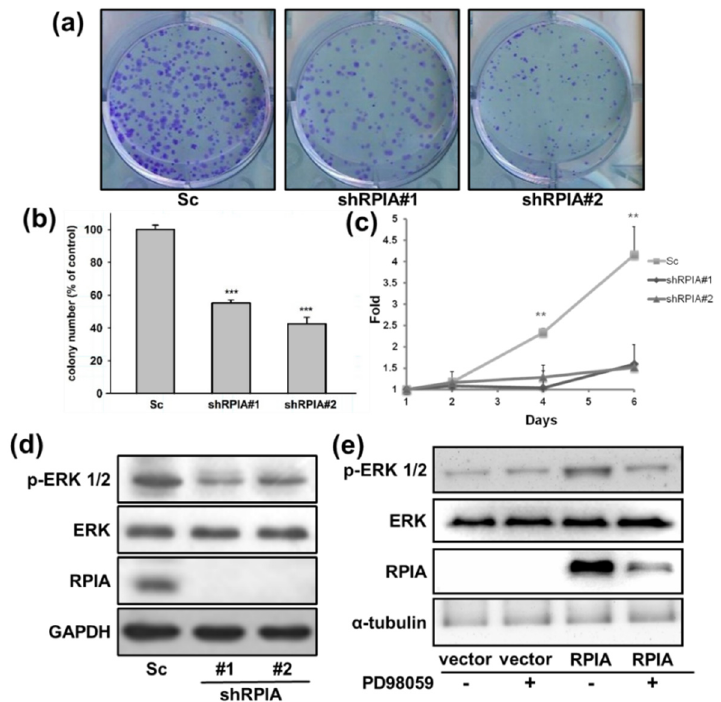
Figure 3. Knockdown of RPIA decreased the oncogenicity of A549 cells. ( a ) For colony formation assay, shRPIA-A549 cells were seeded at a density of 500 cells per well. After 10-day incubation, the cells were stained with crystal violet and the images were photographed for quantitation. ( b ) The colony numbers were further quantified and presented as the relative percentage compared to Scramble (Sc). Statistical analyses were conducted by Student T-test, *** p < 0.001. ( c ) Knockdown of RPIA decreased cell proliferation by WST-1 assay. Statistical analyses were done by Student T-test, ** p < 0.01. ( d ) Knockdown of RPIA decreased the levels of phosphorylated ERK1/2 (p-ERK1/2) in A549 lung cancer cell lines by Western blot. ( e ) The elevated p-ERK1/2 levels by overexpression of RPIA in A549 can be reduced by the treatment of PD98059 (10 µ M), an MEK inhibitor. Activated MAPK/ERK (mitogen-activated protein kinase/extracellular signal-regulated kinase) signaling promotes cell proliferation, cell survival and metastasis in tumors